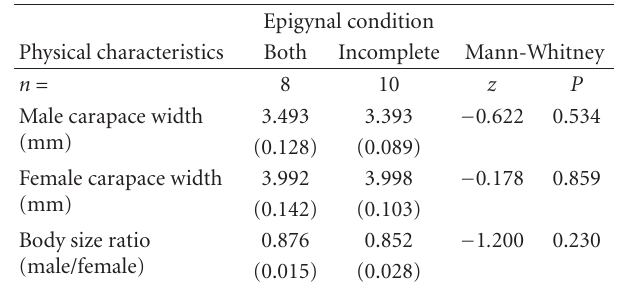
Figure 1: Means ( ± SE) of the residual index for field-collected Peucetia viridans females grouped by combinations of copulatory plugs in their epigyna. Combinations are defined in the text and the number of spiders in each group is indicated in